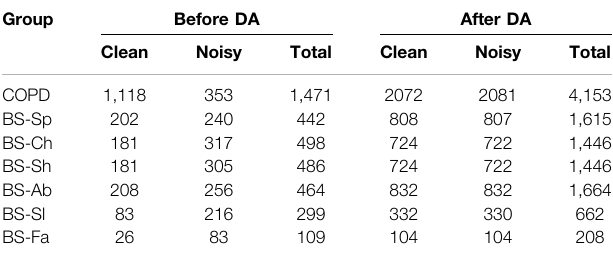
TABLE 1 | Overview of the datasets, indicating the number of segments in each class. The suf fi x corresponds to the type of breathing imposed during the respiratory protocol. On the left, the total number of segments before data augmentation (DA). On the right, the segments after